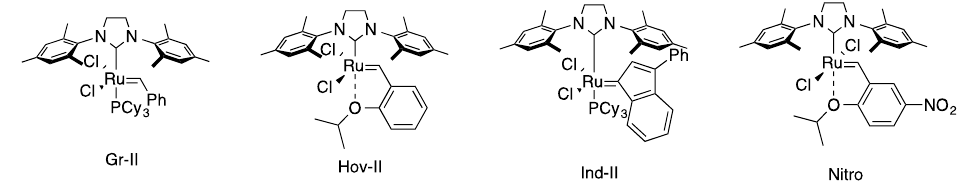
Figure 2. Commonly used types of ruthenium catalysts for olefin metathesis.